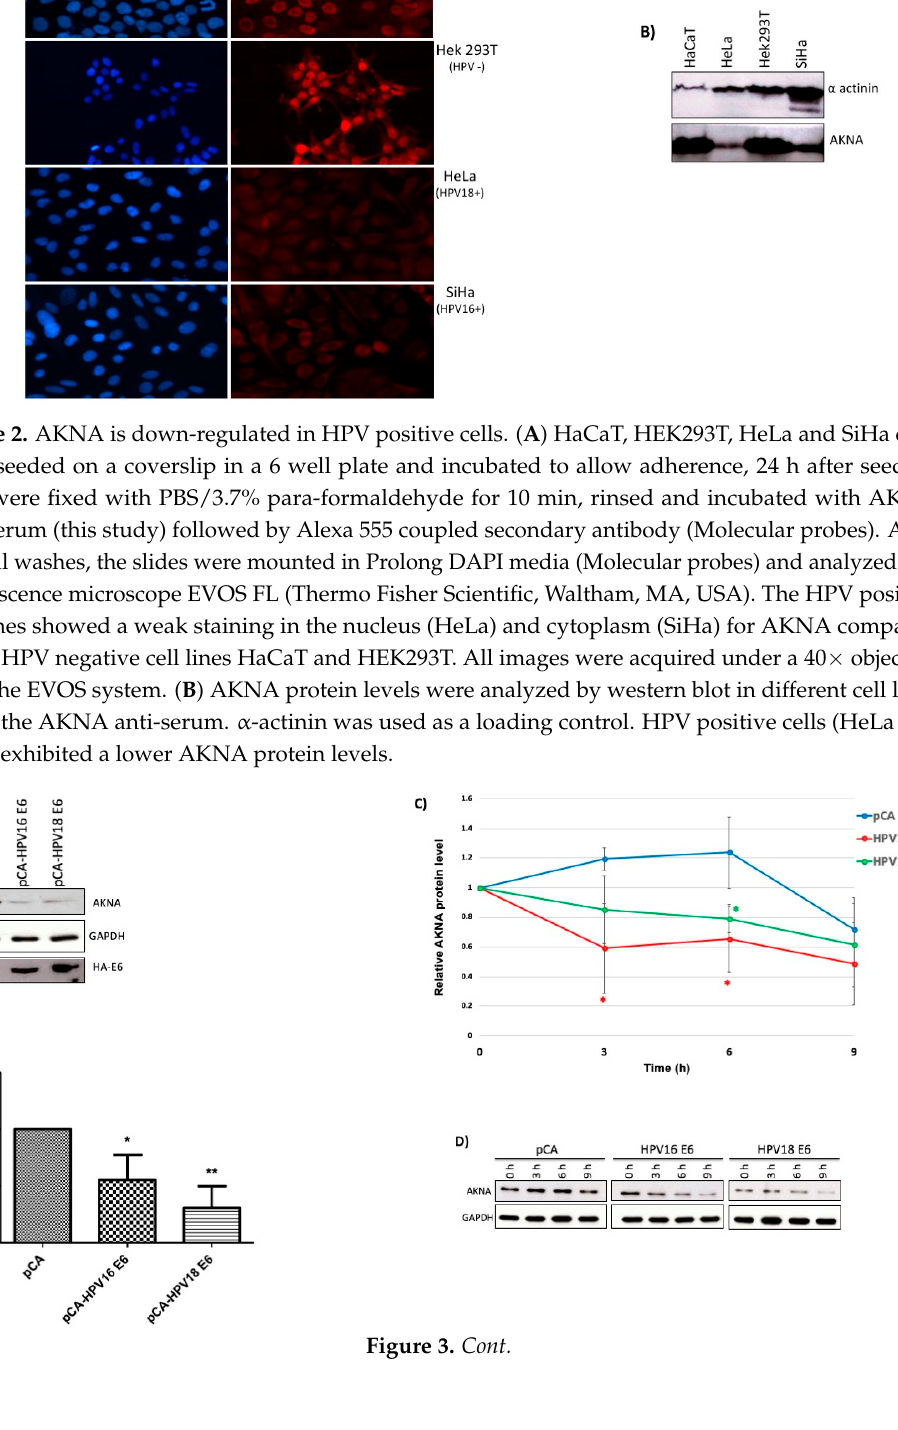
Figure 1. Representative micrographs of conventional histology and immunohistochemistry to detect AKNA in normal and neoplastic cervical epithelium. ( A ) Normal histological appearance of uterine cervix, showing squamous stratified epithelium supported by connective tissue. ( B ) Normal epithelium showing strong AKNA immunostaining. Arrows indicate koilocytes where AKNA staining is absent. ( C ) Intense cervicitis with small fragment of epithelium (asterisk) and large nodules of neoplastic cells in subjacent connective tissue that correspond to infiltrating areas of mild differentiated squamous cell carcinoma (arrows). ( D ) Conserved epithelium (asterisk) and neoplastic nodules (arrows) show slight AKNA immunostaining (panels A and B 200× magnification, panels C and D 100× magnification). ( E ) Digital pathology study confirmed AKNA reduced levels in cancer